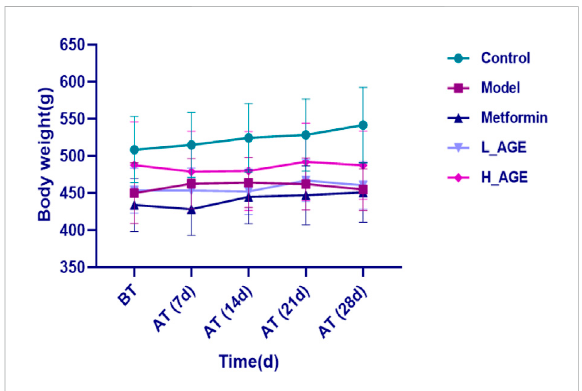
FIGURE 1 Body weight change of control, model, and treatment